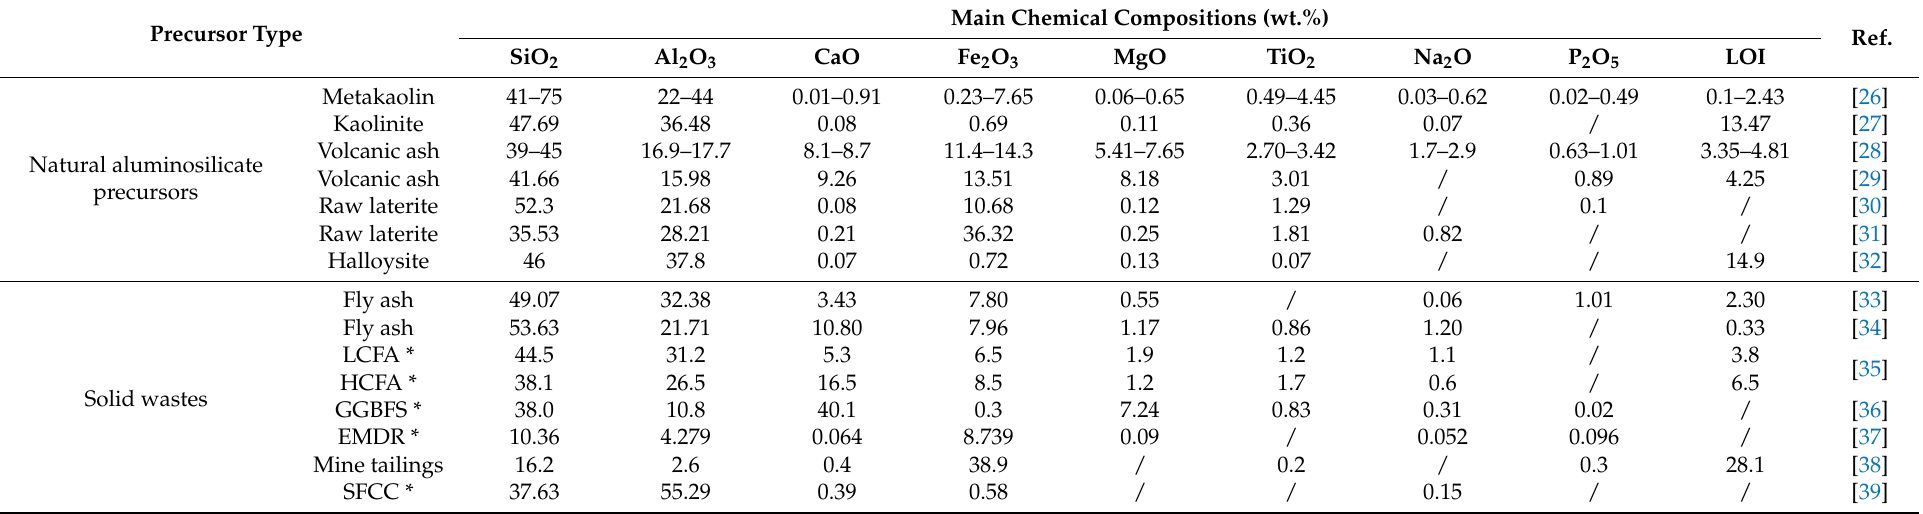
Table 1. Main components of commonly used aluminosilicate